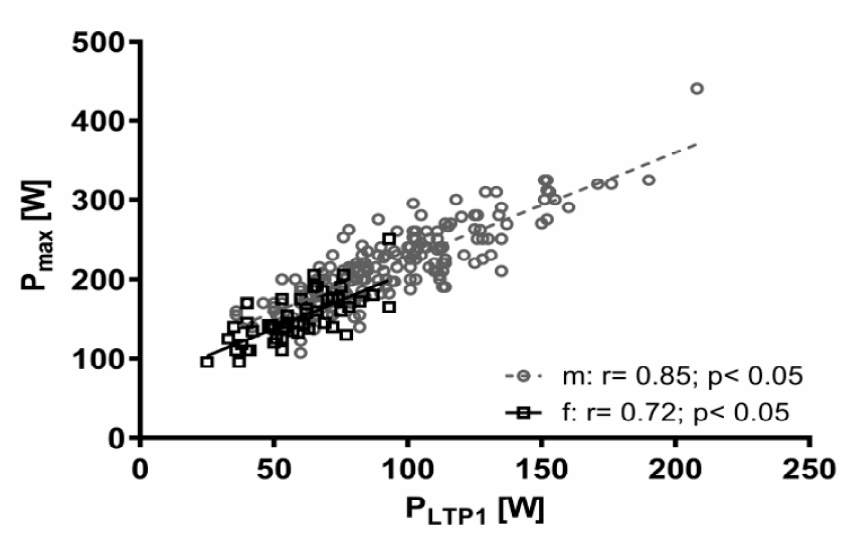
Figure 2. Relationship between power output at the first lactate threshold (P LTP1 ) and maximum power output (P max ) for male (m) and female (f)